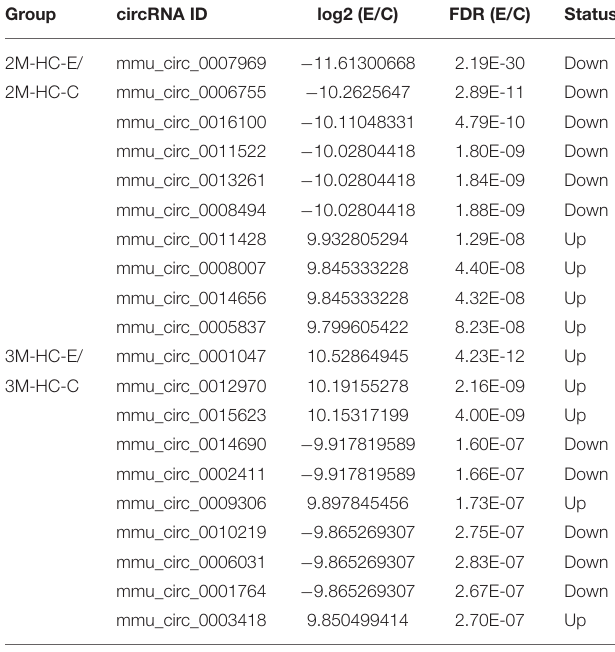
TABLE 4 | Top 10 dysregulated circRNAs in Kupffer cells of murine liver after E. multilocularis infection.